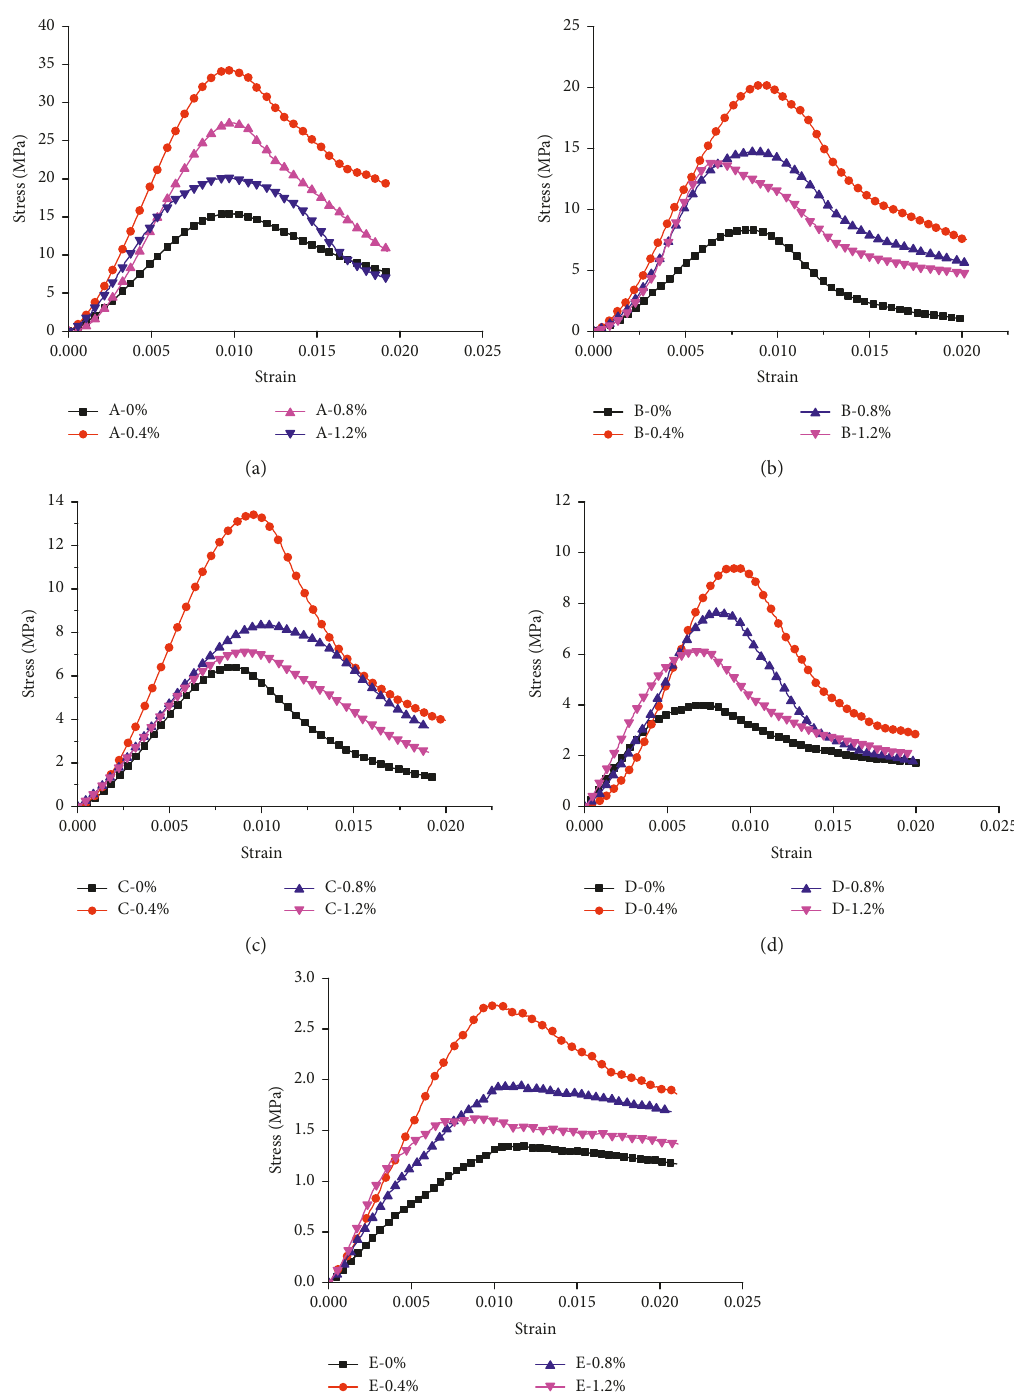
Figure 3: Experimental stress-strain curves of BF-CRM under uniaxial compression: (a) A group; (b) B group; (c) C group; (d) D group; (e) E